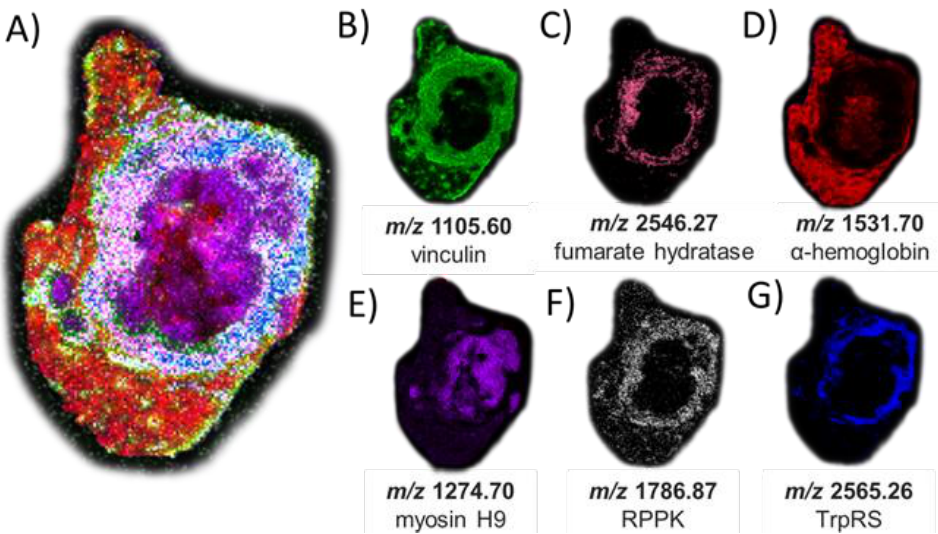
Figure 5. MSI of peptide signatures observed after on-tissue PNGase F and OGA treatments and trypsin digestion (and matched to peptides characterized using in-situ gel trypsin LCMS/MS analysis that correspond to known proteins). ( A ) Co-registered collection of peptide matches. ( B ) m/z 1105.60 ( − 0.9 ppm error) corresponding to vinculin; ( C ) m/z 2546.27 ( − 6.5 ppm error) corresponding to fumarate hydratase; ( D ) m/z 1531.70 ( − 8.9 ppm error) corresponding to hemoglobin alpha; ( E ) m/z 1274.70 ( − 0.1 ppm error) corresponding to myosin heavy chain 9; ( F ) m/z 1786.87 ( − 6.1 ppm error) corresponding to ribose-phosphate diphosphokinase; and ( G ) m/z 2565.26 (6.2 ppm error) corresponding to aminoacyl tryptophan-tRNA synthase. The H&E stain of the same tissue section is shown in Figure S8 for reference and matched peptide sequences and protein identities are reported in Table S3.